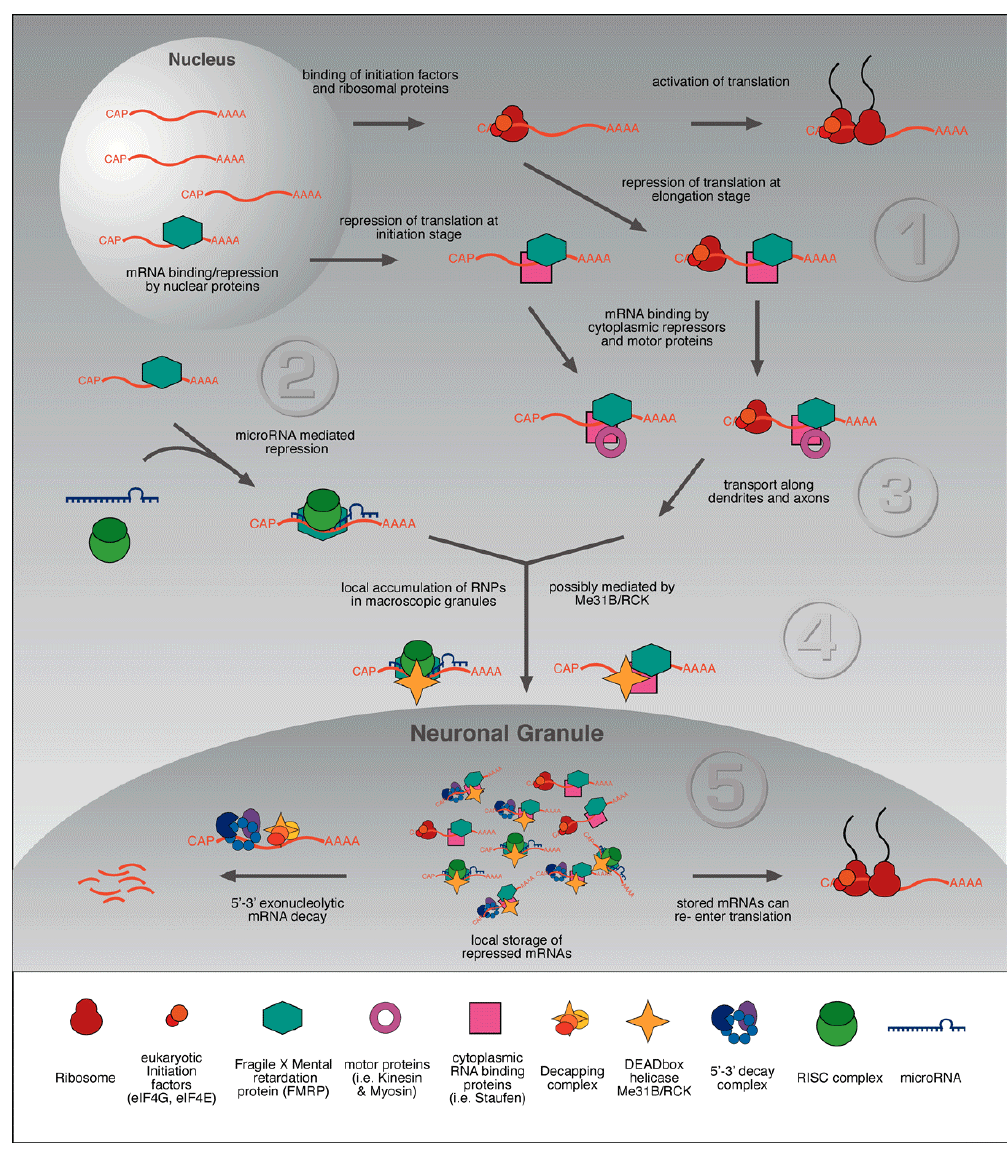
FIGURE 1 . Model. Local protein synthesis in neurons plays a major role in neuronal development and synaptic plasticity. In order to regulate local translation, a neuron uses different mechanisms to repress, transport, store, degrade, and derepress mRNAs. This model gives an overview of different mRNP particles and their interaction. (1) Translation is initiated by the binding of eukaryotic initiation factors (eIFs) and ribosomal proteins to the mRNA. At this stage, specific mRNA binding proteins can repress translation at the elongation stage. Alternatively, mRNAs can be repressed before ribosomal proteins bind to the mRNA, blocking translation at the initiation stage. mRNPs containing mRNAs blocked at those two stages can be distinguished by the presence or absence of ribosomes. (2) The miRNA pathway represents an alternative way to repress mRNA translation. miRNAs are noncoding small RNAs (on average 22 nt long) derived from double-stranded pre- miRNAs. When attached to the RISC, miRNAs bind to specific sequences in the UTR of their target mRNAs and repress translation. As many miRNAs are expressed in the nervous system and a role for miRNAs in synaptic plasticity and memory formation has been shown, a major role for miRNA-mediated translational repression in neurons is implicated. (3) Translationally repressed mRNAs are bound by specific RNA binding proteins, translational repressors, and motor proteins, and form diverse mRNPs, which are transported along dendrites and axons. (4) Locally, i.e., at synapses or dendritic branch points, diverse mRNPs accumulate in macroscopic NGs. A main component of NGs is the DEAD-box helicase Me31B/Rck, which is required for the formation of somatic P-bodies; thus implicating a role for Me31B/RCK in the formation of macroscopic NGs. (5) NGs are highly dynamic structures. FRAP experiments in neurons showed that proteins and mRNAs can enter and exit mRNP particles very rapidly. Furthermore, recent data suggest that NGs are cellular compartments where mRNAs are remodeled and sorted. mRNAs can either be repressed and stored locally, enter the decay pathway (proteins involved in 5’-3’ exonucleolytic decay are present in NGs), or mRNAs can exit NGs and re- enter translation, resulting in local protein